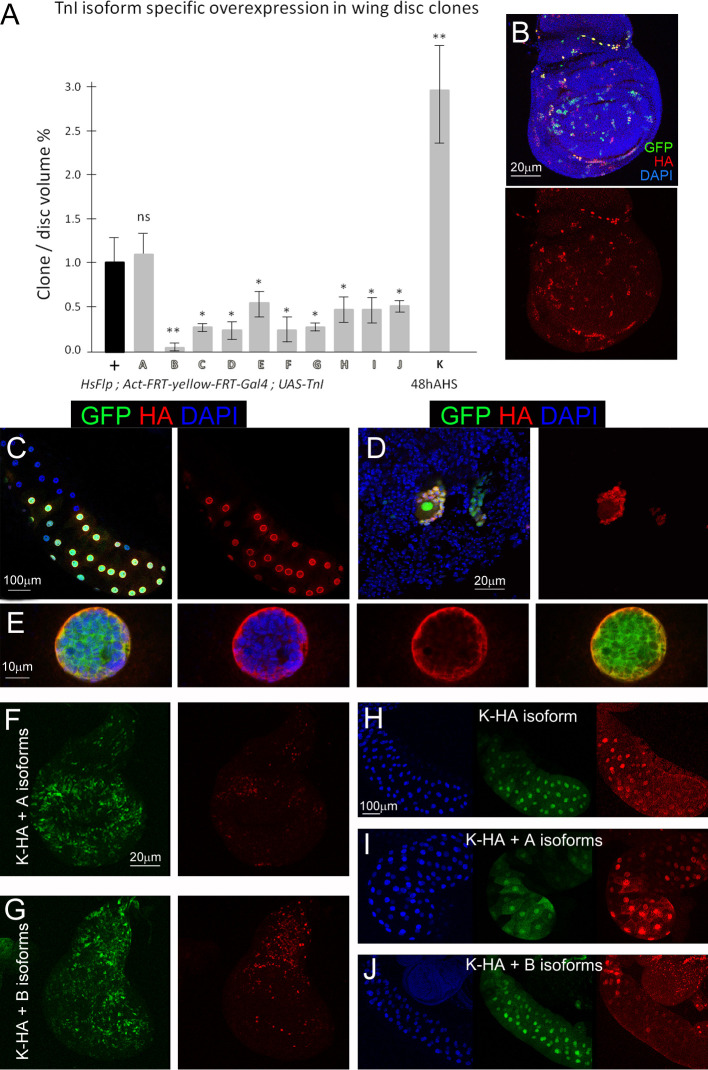
TnI isoforms are functionally different and interacting. A) Cell proliferation effects of single TnI isoforms overexpression.Somatic clones were induced in the larval wing discs (genotype: ♀♂ hsFlp; act-FRT-yellow-FRT-Gal4/+; UAS-TnIisoformX/+) screened 48h after heat shock (48AHS). Note that, with the exception of A, all white isoforms reduce cell proliferation. By contrast, the black isoform tested (K), yields a significant proliferation increase. Since all black isoforms (K, L and M) yield the same protein, only one was tested. B-E) Nuclear localization of isoform K. B) Images of larval wing disc somatic clones expressing the HA-tagged K isoform (red) and the cell reporter GFP to identify the clones. Nuclei are stained by DAPI (blue). C) Equivalent clones in the salivary glands and D) the neuroblast descendants in the central nervous system. E) Lower row of panels show one salivary gland nucleus stained for DAPI (blue) and TnI (red). Note the nuclear localization of K-HA, mostly in the periphery. F-J) The nuclear localization of isoform K is interfered by isoforms A or B. Equivalent clones co-expressing TnI isoforms K-HA and A or B in wing imaginal discs (F, G) or salivary glands (H-J). The nuclear localization of isoform K is efficiently prevented by isoform A and, to a higher extent, by isoform B.